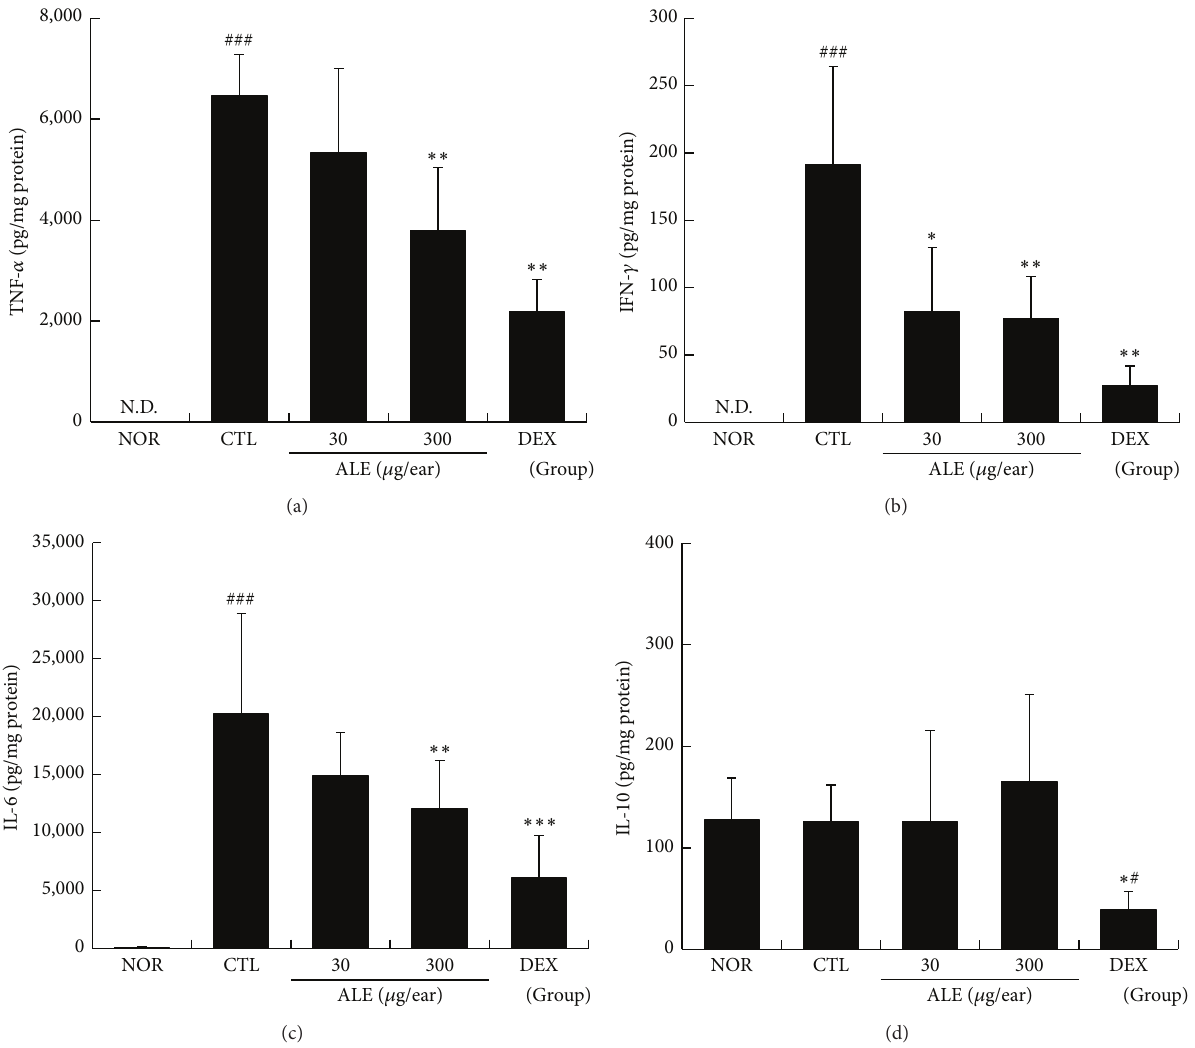
Figure 4: Effect of ALE on production levels of cytokines in inflamed tissues. The cytokine levels in inflamed tissues were evaluated. (a) TNF- 𝛼 ; (b) IFN- 𝛾 ; (c) IL-6; (d) IL-10. N.D., not detected. Values are presented as the means ± SD. # 𝑃 < 0.05 and ### 𝑃 < 0.001 compared to the NOR group and ∗ 𝑃 < 0.05 , ∗∗ 𝑃 < 0.01 , and ∗∗∗ 𝑃 < 0.001 compared to the CTL